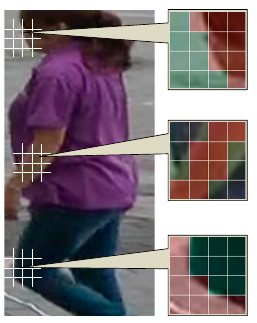
Figure 1. Correlation-adaptive partitioning of feature embeddings.